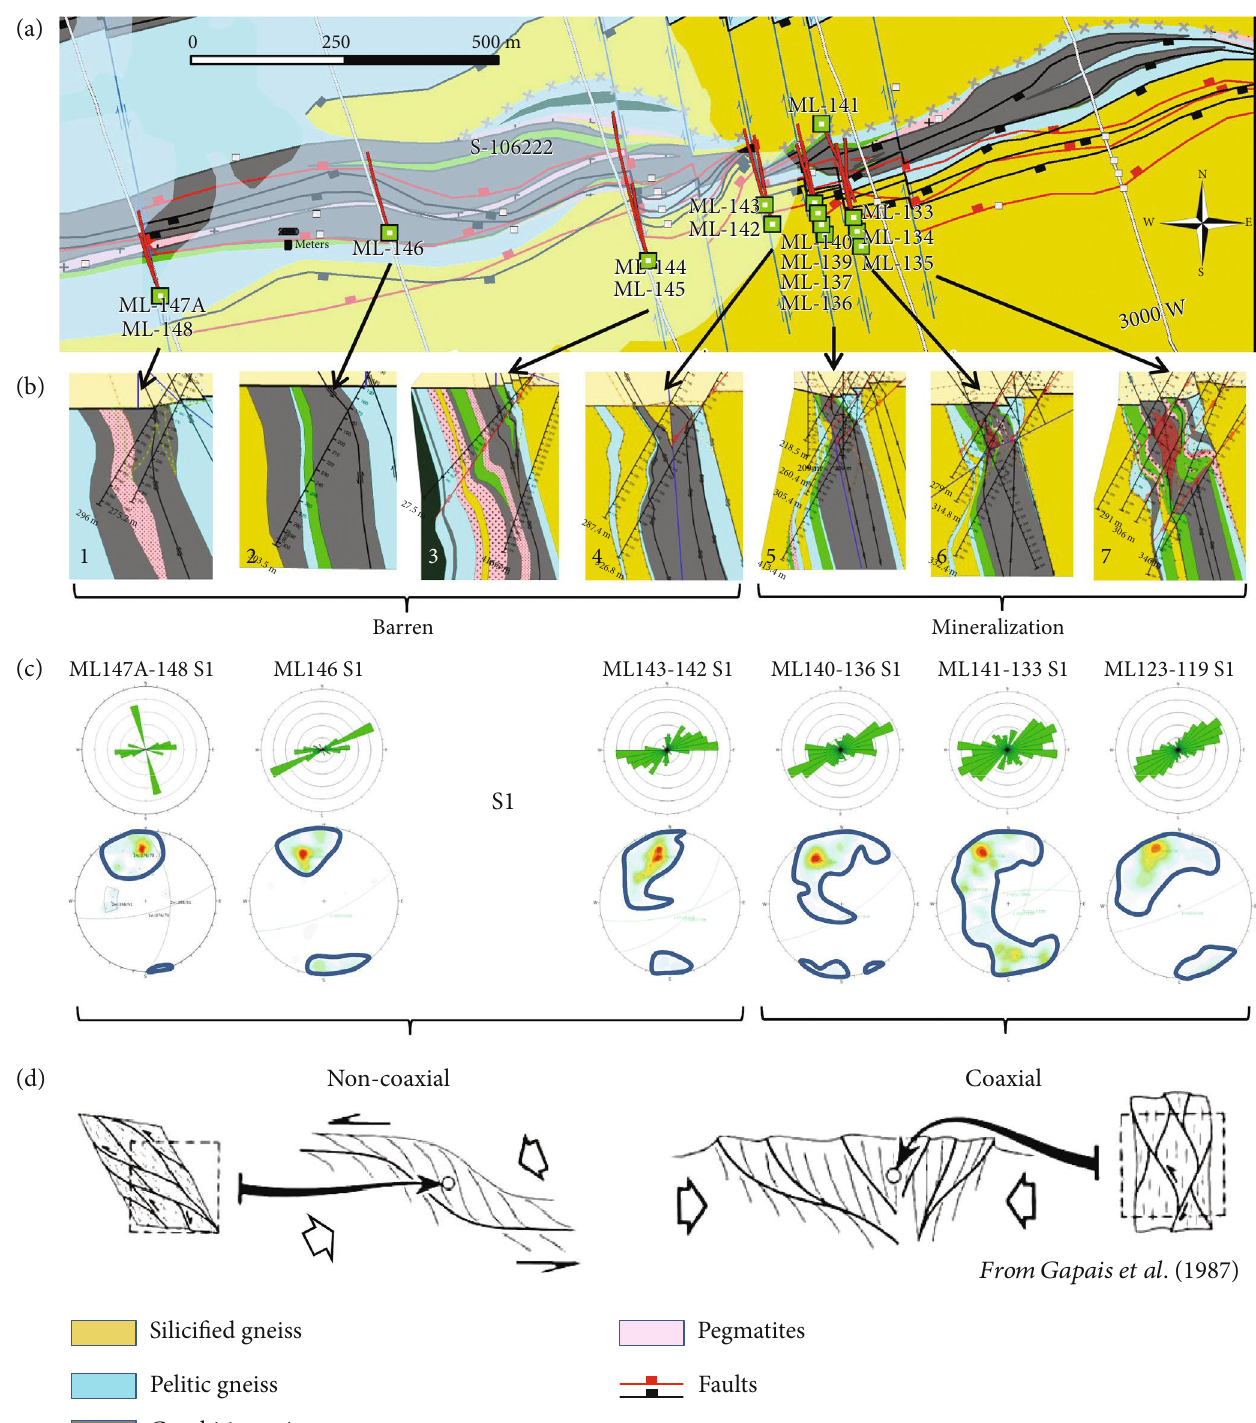
Figure 9: Location of the revisited drill holes (a) and sections (b) along the Tri-Island conductor, Martin Lake Project. Orano ’ s map and sections. (c) Rosacea and plane poles stereoplots (contours) of oriented data of foliation (S1) (Orano ’ s database) and inferred transposed shear zones from the barren far west moving into the mineralized zone (red) to the East. (d) Cartoons showing the 2D shear zone pattern resulting from noncoaxial versus coaxial mineralization at 209.8 m appears spatially related with a moderate clay alteration (muscovite/illite). Microfractures fi lled by secondary graphite (or dark chlorite) are frequent 15-20 cm thick fault zone (Figure 11(c)). Fault-related frac- tures are subparallel to foliation and oriented E-W. Uranium (Figure 11(b)). The uppermost interval of medium-grade